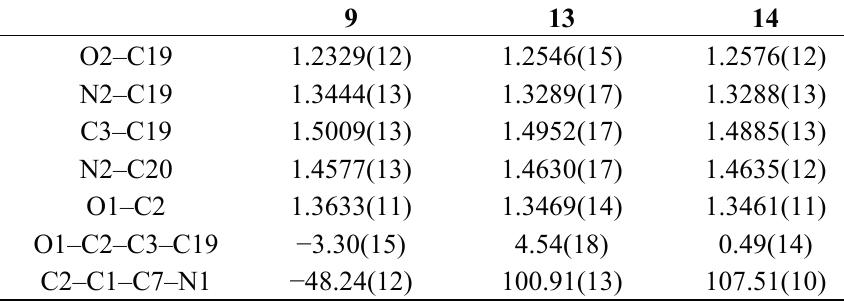
Figure 7. ( a ) Crystals grown for 9 ; ( b ) molecular structure of 9 (drawn at a 50% probability level; dashed lines: hydrogen bonding). Table 4. Selected interatomic distances (Å) and torsion angles